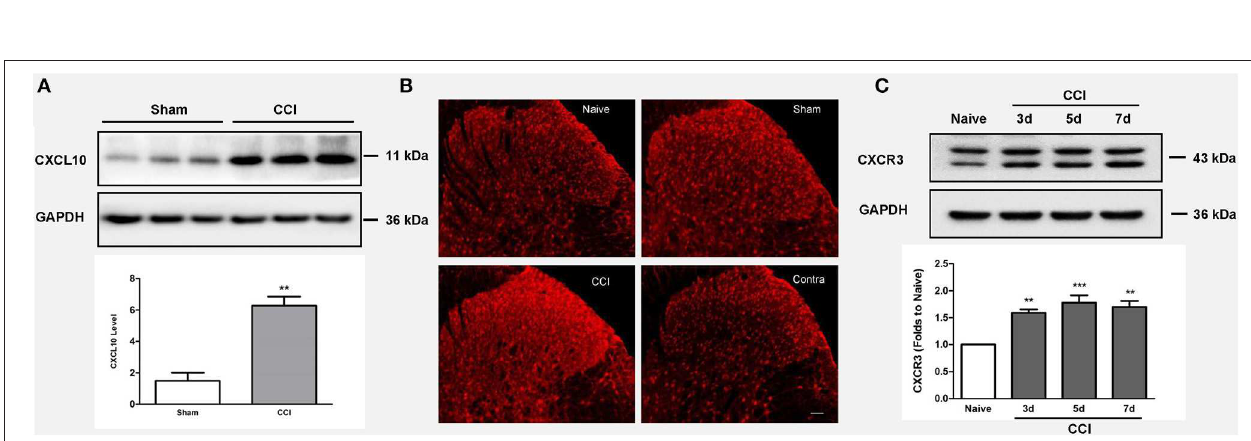
FIGURE 3 | CCI induces CXCL10/CXCR3 signaling activation. (A) Upregulated CXCL10 expression is observed in the ipsilateral spinal cord after CCI injury (** p < 0.01; independent t -test, n = 3). (B) Immunohistochemistry reveals the CCI-mediated induction of CXCR3 activation. (C) The spinal CXCR3 protein level increased during days 3–7 after CCI as shown by western blotting (** p < 0.01; *** p < 0.001; ANOVA, n = 3). The data are presented as means ± standard errors. GAPDH was used as a loading control. ANOVA, analysis of variance; CCI, chronic constriction injury; CXCL10, C-X-C motif chemokine 10; Contra, contralateral to CCI.